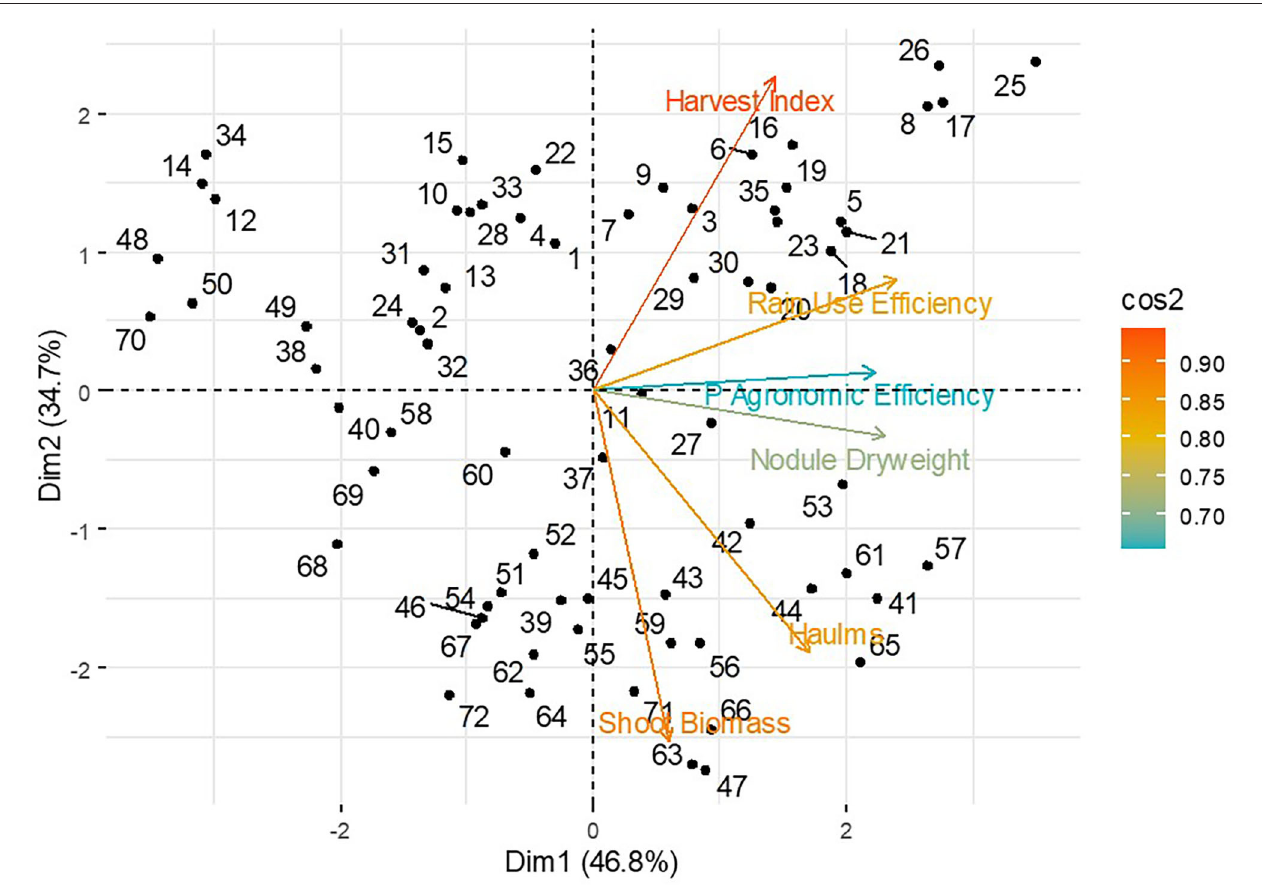
FIGURE 2 | Principal component analysis of soybean yield